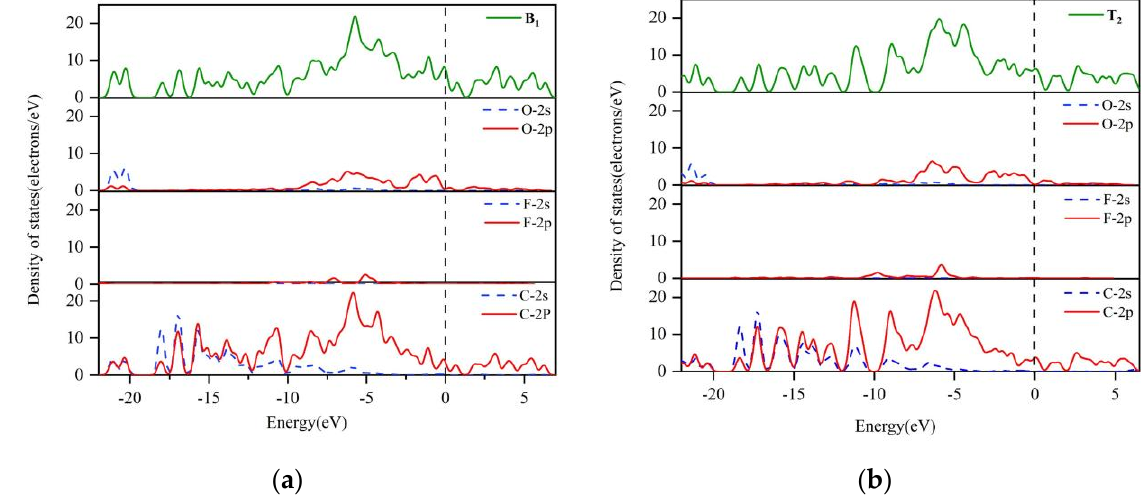
Figure 9. Total density of states and the projected density of states of O, C and F atoms: ( a ) adsorbed at B 1 site; ( b ) adsorbed at T 2 site.